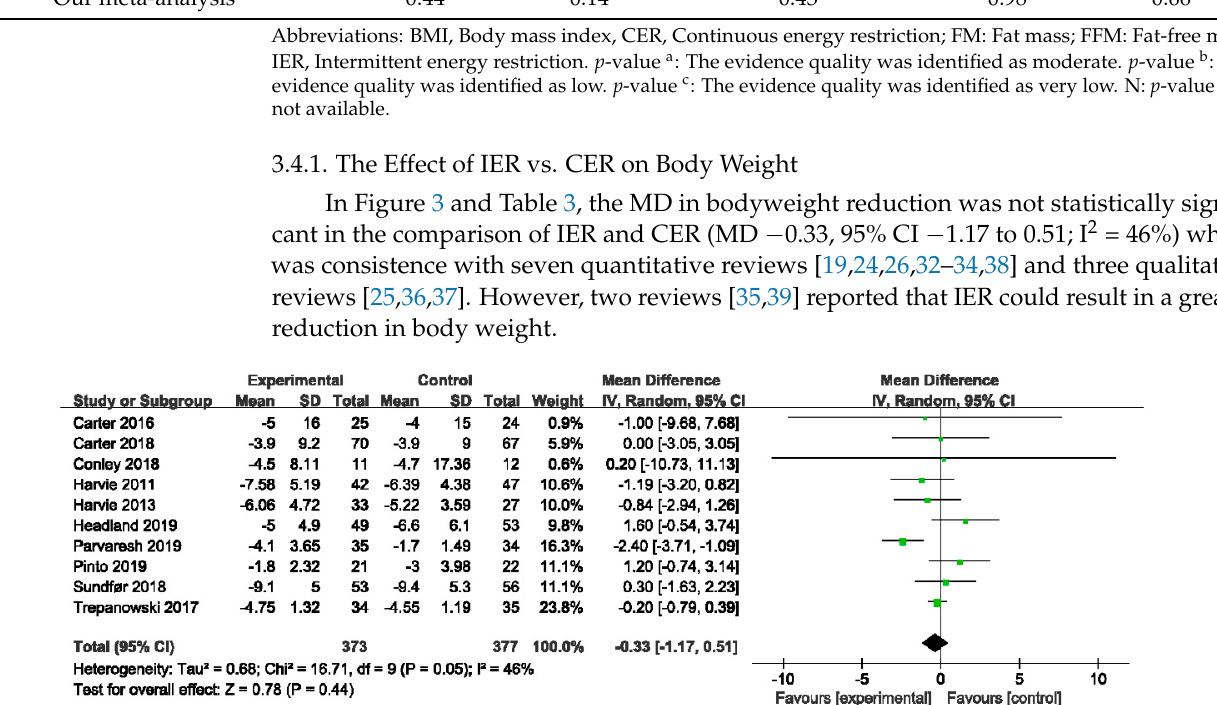
Figure 4. Forest plot for BMI in trials that compared IER with CER. Abbreviations: CI, confidence interval; BMI, body mass index; IER, intermittent energy restriction; CER, continuous energy re- striction . The unit of mean difference in BMI is kg/m 2 . 3.4.3. The Effect of IER vs. CER on Waist Circumference In Figure 5 of our meta-analysis, trials comparing IER with CER showed no statisti- cally significant effect regarding waist circumference (MD − 0.71, 95% CI − 2.49 to 1.06; I 2 = 66%) in consistence with six quantitative reviews [19,24,26,32,35,39] and two qualitative reviews [25,36]. However, IER showed a greater reduction in waist circumference com- pared with CER in the results of Harris and Hamilton et al. [33] (MD − 2.14, 95%CI − 3.53 to − 0.75, p = 0.002) (Table 3). We found the heterogeneity in the subgroup analysis and sensitivity analysis could not be formally assessed in the insufficient studies with different variables among study designs.